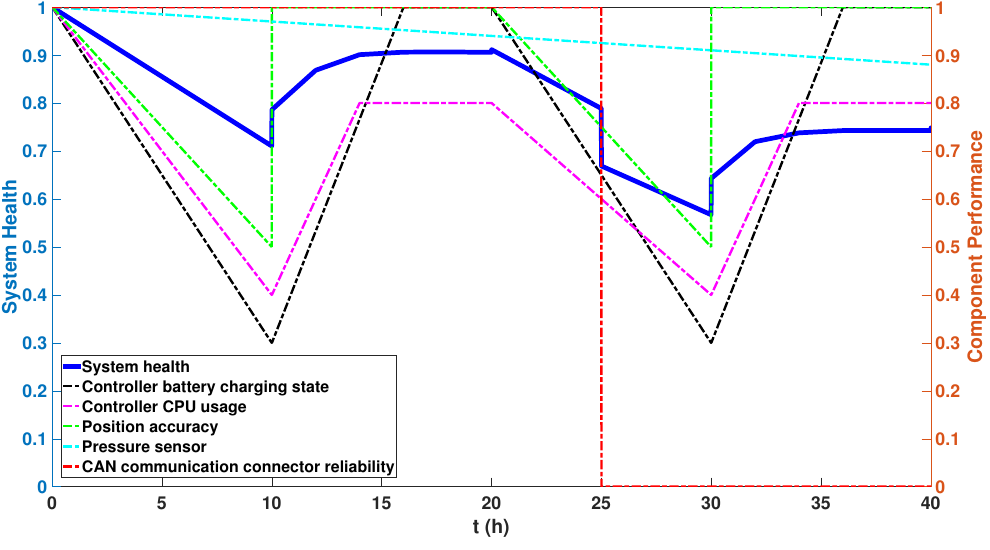
Figure 6. The simulation results of scenario case 3.